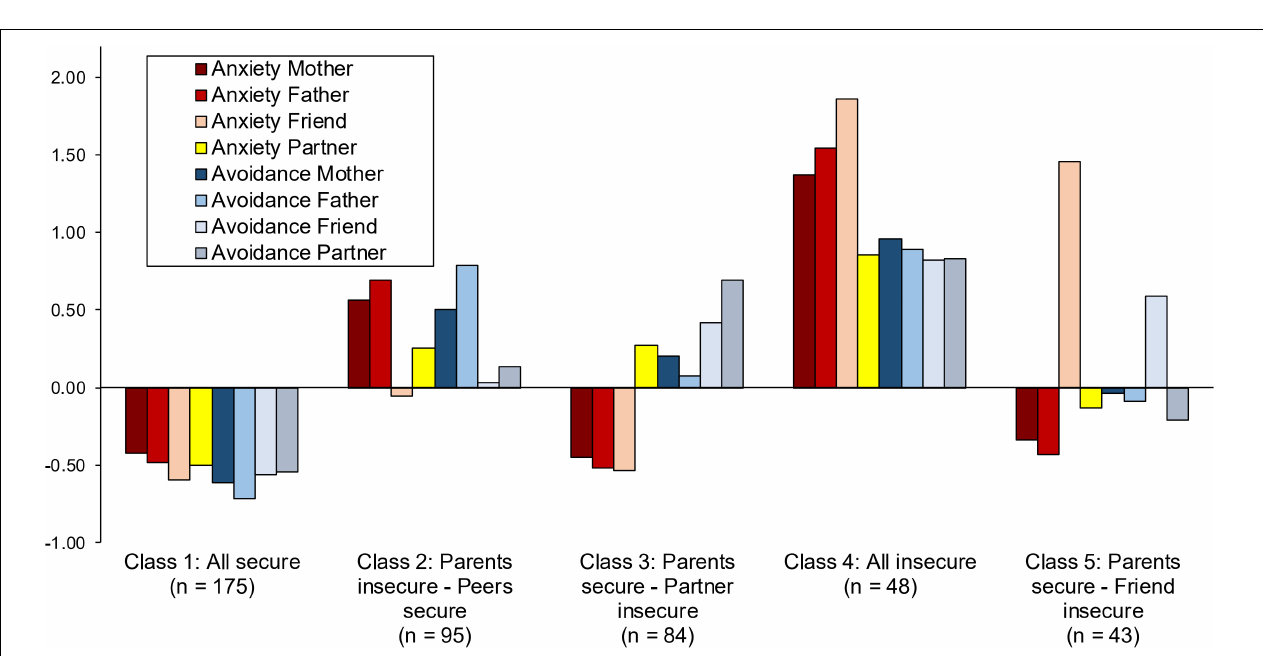
FIGURE 1 | Standardized means of indicator variables for adolescent latent attachment